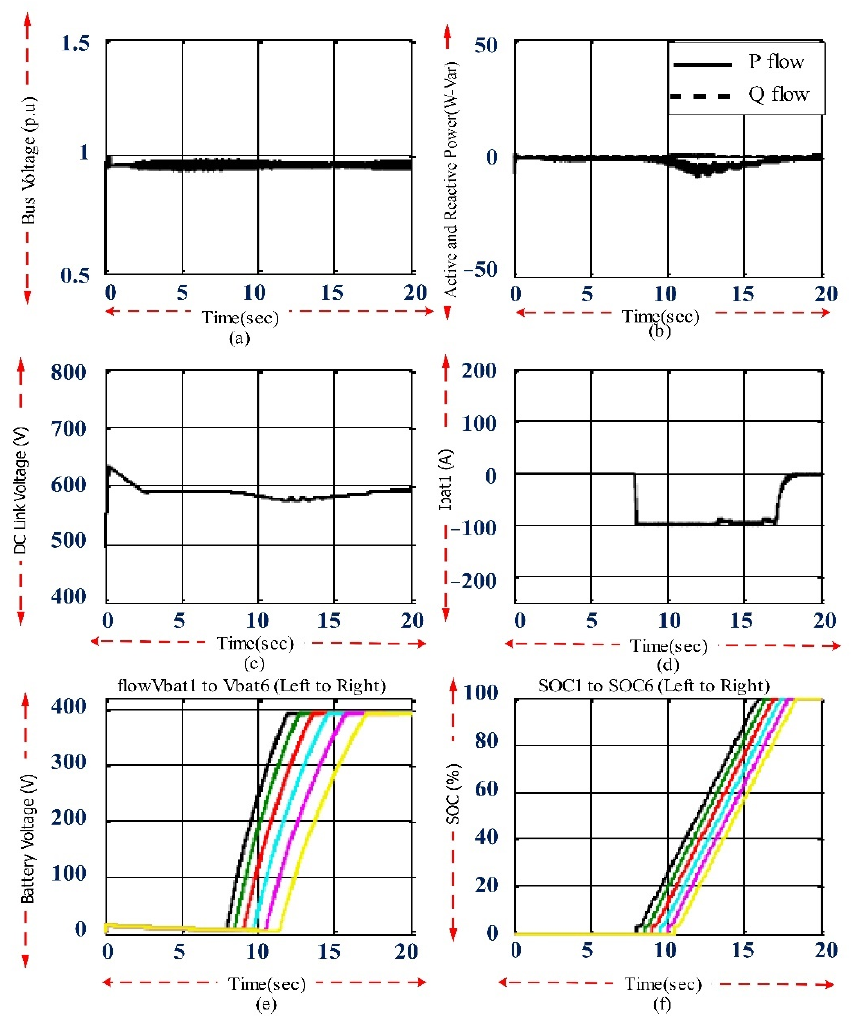
Figure 19. The results of fast charging of EVs connected to the grid and diesel ( a ) grid bus voltage; ( b ) active and reactive power exchange of the grid bus with the EV system; ( c ) DC link voltage; ( d ) battery current; ( e ) battery voltage; ( f ) SOC.